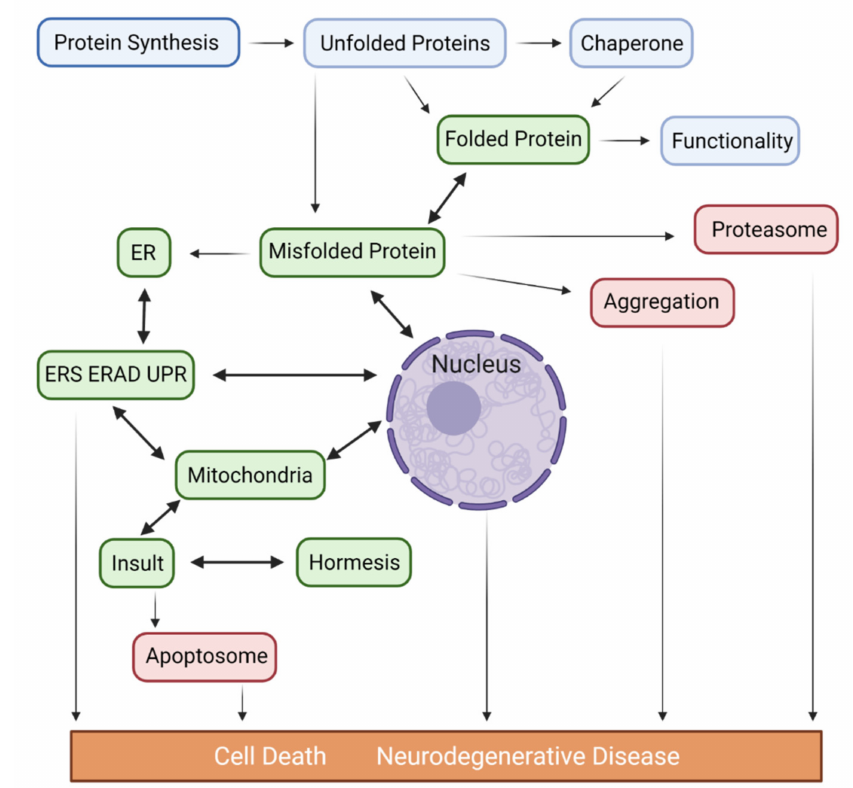
Figure 1. Proposed pathways depicting the potential role of misfolded proteins and the contribution of ER/Mitochondria/Nucleus in the pathogenesis of major ND. Accumulated unfolded/misfolded proteins in the ER may either be degraded by ERAD or activate the UPR, which induces a set of transcriptional and translational events to the nucleus through activation of 2 transcription factors (ATF6 and XbP1s), an unspliced X-box binding protein1 (XbP1u) and mitochondria via IRE1 α /PERK/ATF6 α , 3 ER transmembrane protein sensors to restore ER homeostasis via adaptive mechanisms. Conversely, if ER stress persists chronically at high levels, a terminal UPR signal induces cell death via the activation of CHOP/GADD34/DR5/BCL2 when damage is irreversible. Chronic ER stress and defects in UPR signaling are contributors to ND. In addition to UPR, the excessive transfer of Ca ++ to the mitochondria also leads to enhanced ROS production (oxidative stress) and mitoproteases (BAX/BAK-dependent apoptosome) activation. Depending on the proteostasis context in ND subtypes and their pathological conditions, ERS may trigger distinct signaling pathways. Pro- teasomes are multicatalytic protease complexes that selectively degrade target proteins into peptide fragments to maintain protein